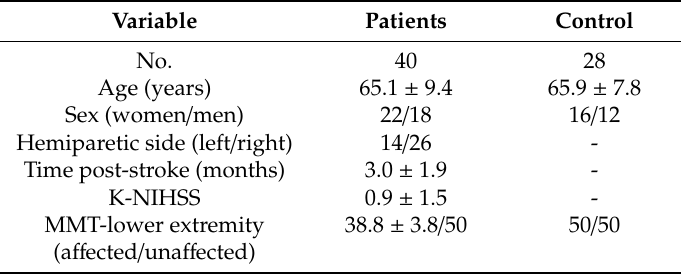
Table 1. Characteristics of the study